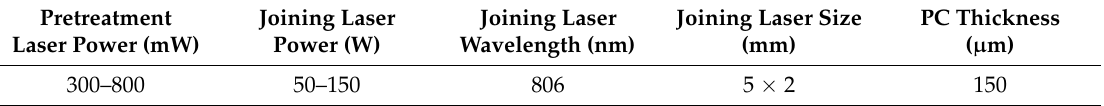
Table 3. Laser joining